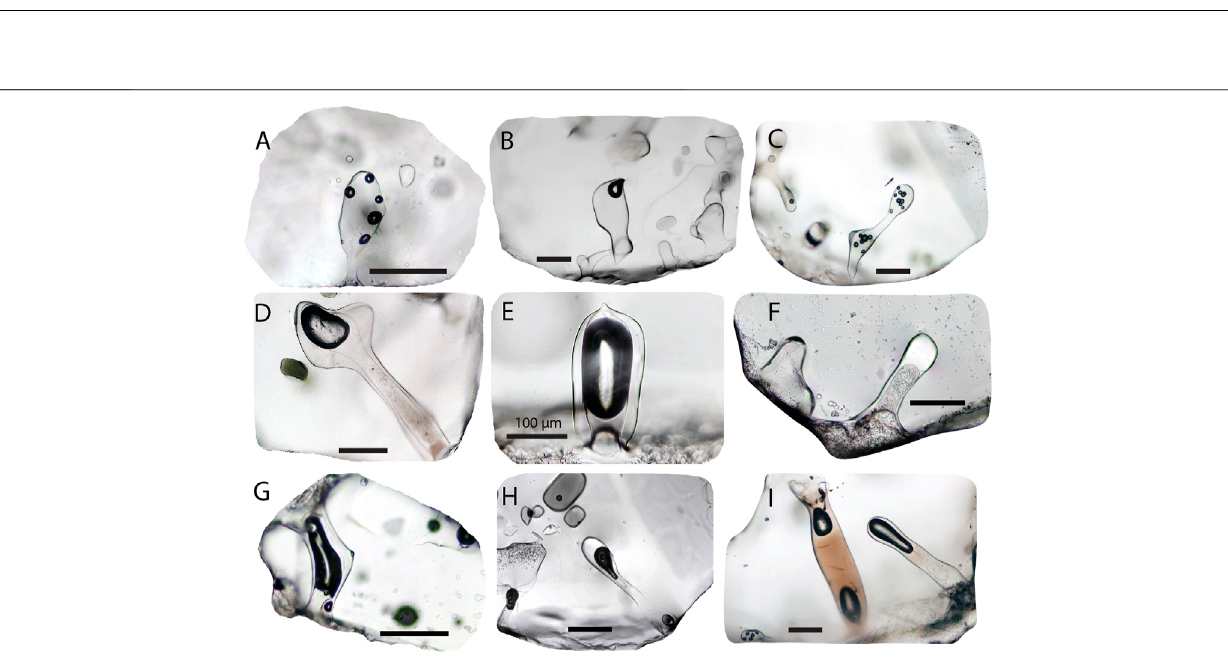
Frontiers in Earth Science |